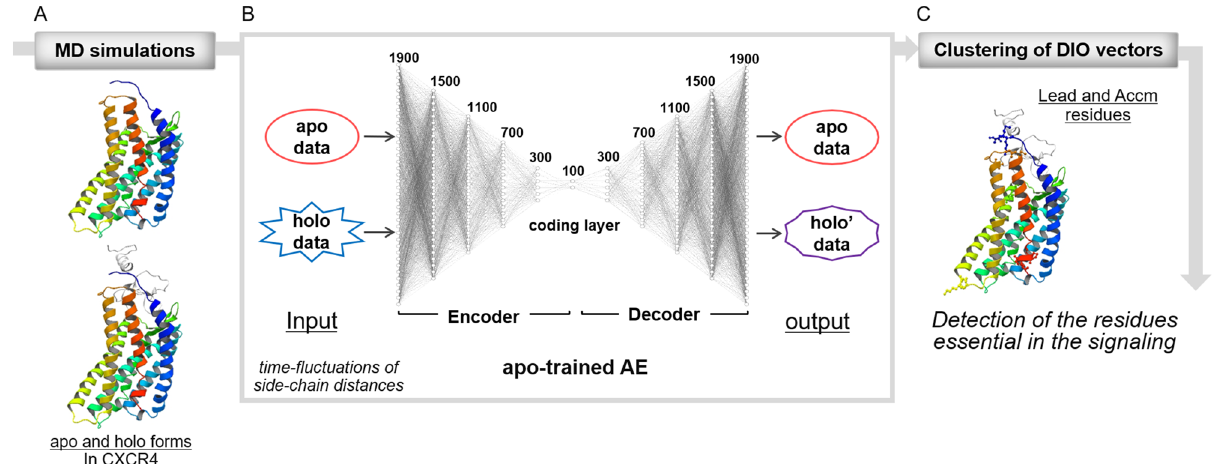
Figure 1. Architecture of autoencoder-based detection of residues essential in signaling. (A) Executions of the MD simulations of apo and holo forms. (B) Training of AE using apo data, and the inspections of apo and holo data using the apo-trained AE. The AE consists of a six-layered encoder and decoder, and a coding layer. The vectors of the side-chain distances during the simulations were inputted into the AE. The output from the inspection of the apo data was almost the same as the input data, whereas that of the holo data showed differences from the input data because of the modification according to the apo features. (C) The clustering of the differences between input and output (DIO) vectors used to extract the residues essential in signaling, as Lead and Accm TM5 and TM6, respectively, as shown in Fig. 2, where the definitions of the helix and turn regions (colored from blue to red) were described) had large RMSF values of Cα atoms in apo1, holo1, and holo2. This turn was involved in the conformational changes in TM5 and TM6 through ligand binding, and is also known to be involved in the signal transmission to the G protein. They suggest that the conformations around the turn between TM5 and TM6 were more flexible in holo form than in apo form. The RMSDs of the Cα atoms around the turn between TM5 and TM6 indicated that the structural transition at approximately 700 ns, rather than large fluctuations during the simulation, arose only in the apo1 structure (Supple- mentary Fig. S1B online). This might lead to a large RMSF around the TM5–TM6 turn. By contrast, the TM5–TM6 turns in holo1 and holo2 had large RMSFs and stable RMSDs. These observations suggest that the fluctuation patterns in the TM5–TM6 turn regions in holo form were unique and deferred from those in the apo form, which might regulate the transmission of the signal to the G protein. The RMSFs in the turn between TM4 and TM5, which are involved in ligand binding, were slightly larger in the apo (apo1 and apo2) forms than in the holo (holo1 and holo2) forms, indicating conformational freedom through the removal of the ligand.